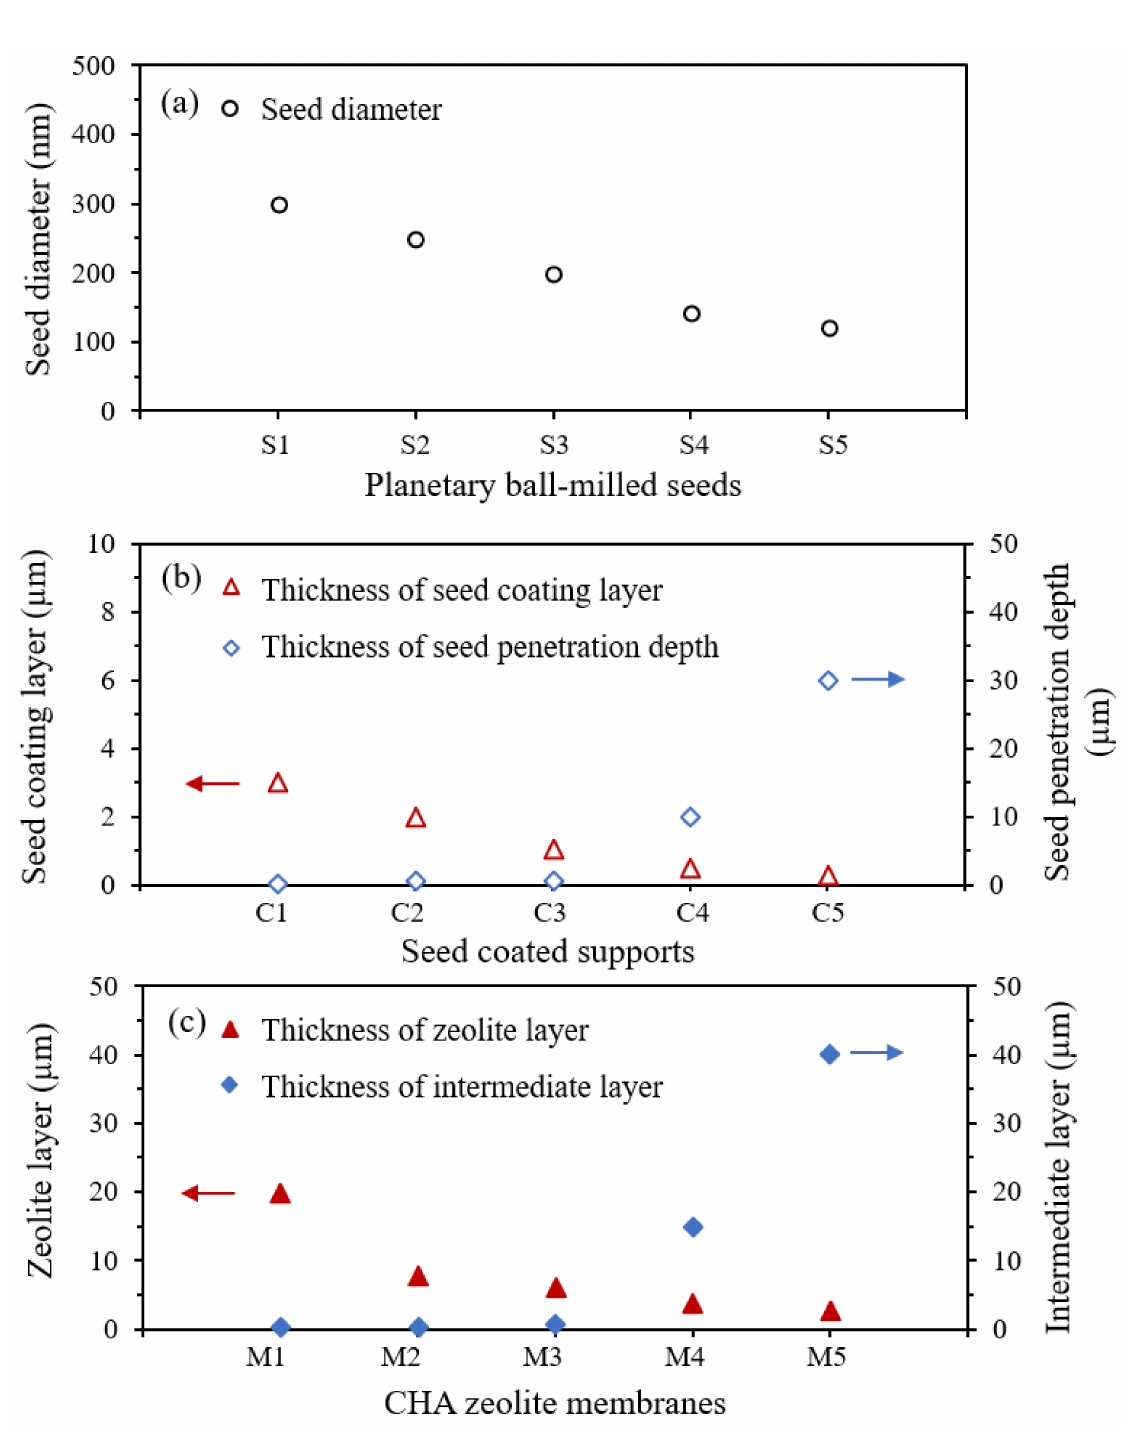
Figure 9. Summary on the variations of ( a ) average seed diameter, ( b ) thickness of seed coating layer and seed penetration depth, and ( c ) thickness of CHA zeolite layer and thickness of the intermediate